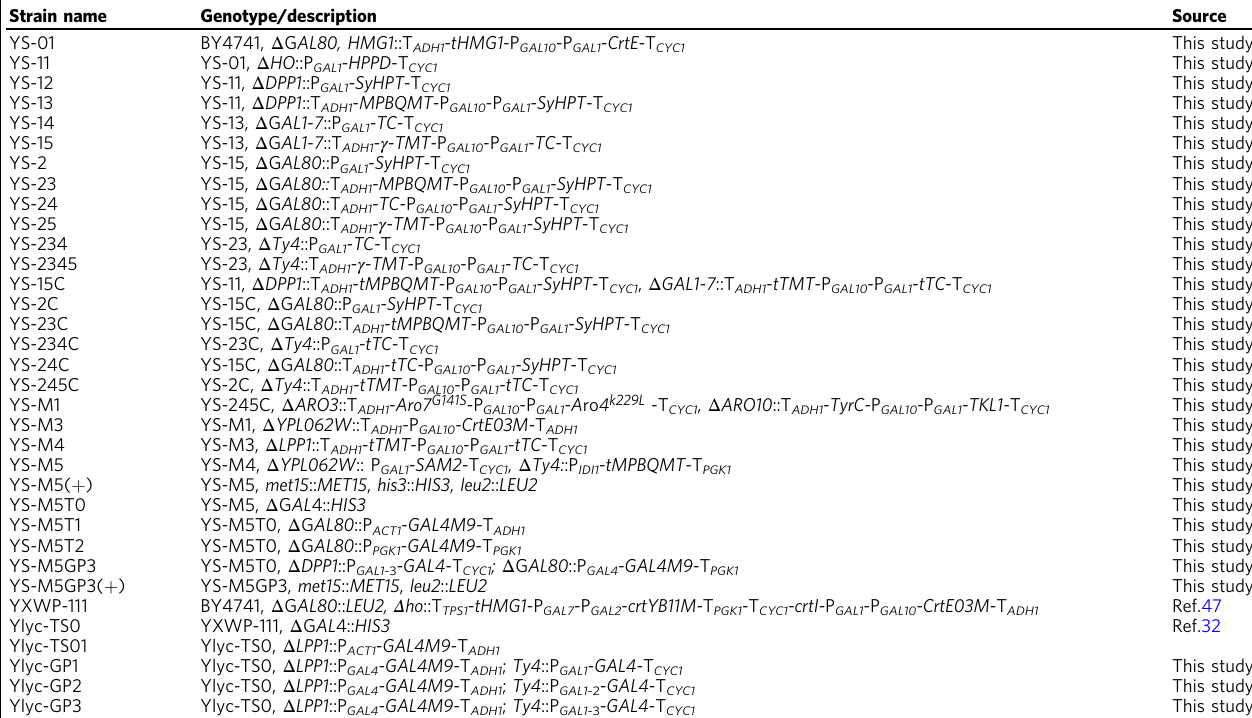
Table 1 Yeast strains used or constructed in this